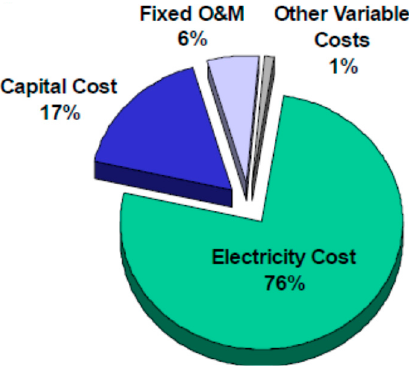
Figure 10. Hydrogen Production, cost breakdown.